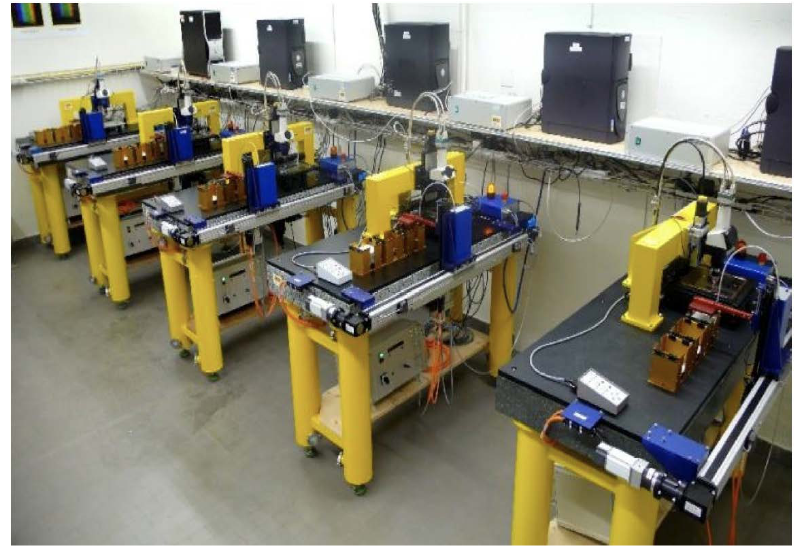
Figure 8. The six automated scanning microscopes of the University of Bern equipped with automated film exchangers. They feature a total scanning speed up to 180 cm 2 emulsion surface per hour.